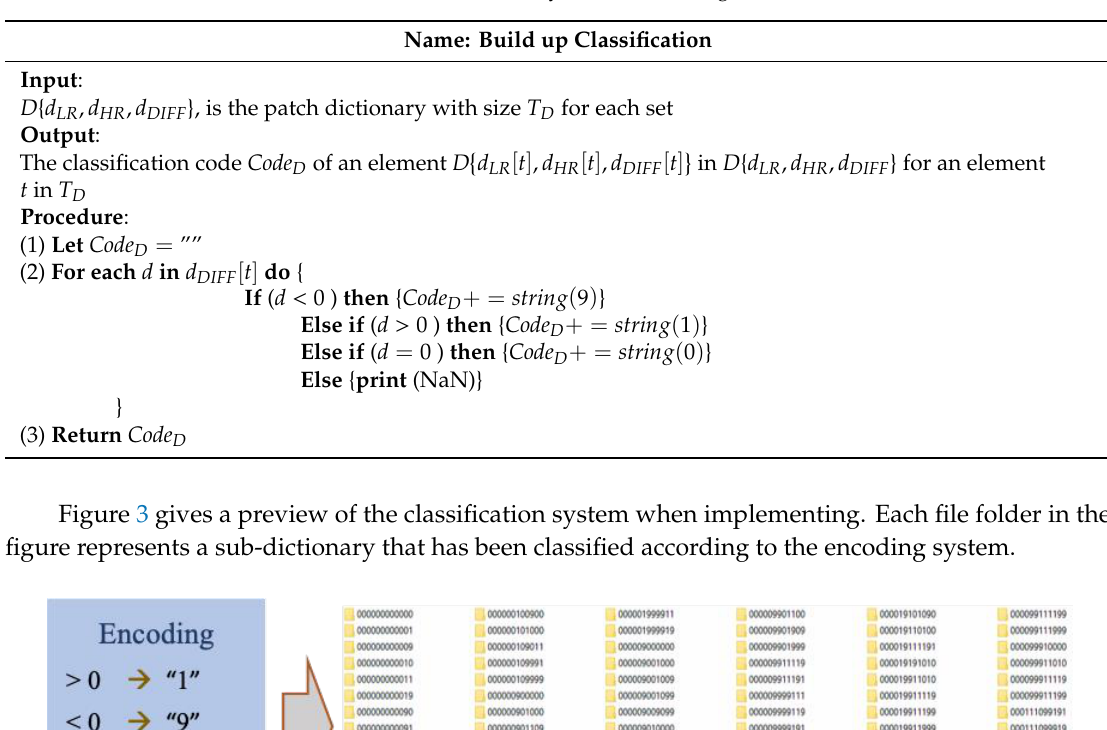
Table 6. Patch dictionary classification algorithm.